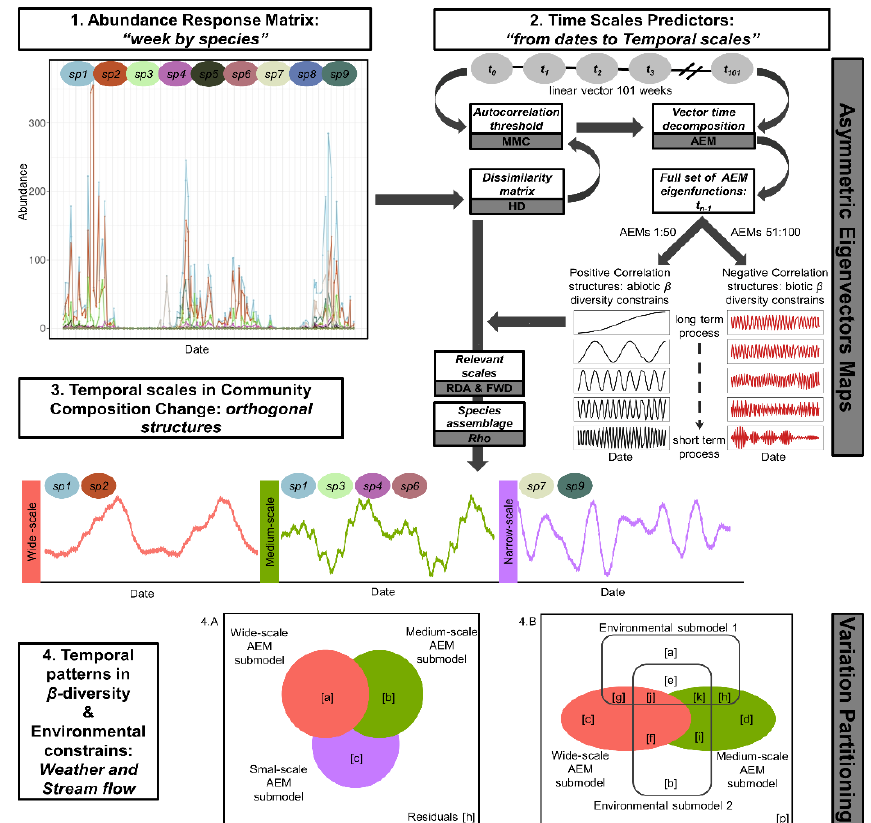
Figure 1. Workflow to analyze Culicoides temporal dynamic and its drivers: the sequence of steps from collecting Culicoides field abundance data, drawing temporal scales and identifying β -diversity scales and their relatedness with environmental variability. White filled boxes outline the aim for each analysis, and dark gray boxes mention the statistical tools used. Step 1 shows the temporal dynamic of the observed abundance in a nine-species virtual community; therefore, it was the response matrix informing weekly community composition. Step 2: the sampling temporal profile was thrown to spectral decomposition by asymmetric eigenvectors maps ( AEMs ) after accounting for the dependency between weeks (autocorrelation threshold). The resulting AEMs were half splitting in positive and negative correlation structures, and a subset was selected by their suitability to model temporal patterns in the observed abundance matrix. Selected subsets were arranged in groups representing broad to narrow temporal waves, hereafter referred to as temporal submodels. Step 3: the community composition change was modeled with each temporal submodel to assess the fitting of the temporal scale on the observed species abundance matrix. The assemblage of species contributing on each significant temporal scale was untangled by the correlation between each species abundance and Lc for each RDA axis . Step 4: the contribution of the temporal submodels and environmental variables to explain the amount of variation was visualized by Venn diagrams after hierarchical variation partitioning analysis. Since temporal scales were nested, even when there were orthogonal structures, both diagrams show intersection areas between temporal submodels as a hierarchical overlapping pattern. Letters inside diagrams are R 2adj for each unique and intersection fraction in the variation partitioning table (as were introduced in section: 2.4. Culicoides β -diversity temporal profile; equations for the fractions are detailed in [84]). AEM: asymmetric eigenvectors maps; AEMs: AEM eigenfunctions; FWD: forward selection; Hd: Hellinger’s distance; Lc: linear combinator scores from an RDA axis ; MMC: multivariate Mantel correlogram; RDA: redundancy analysis; Rho: Rank Spearman correlation; R 2adj : adjusted determination coefficient. This scheme was adapted considering [9,83] (Figure 1).